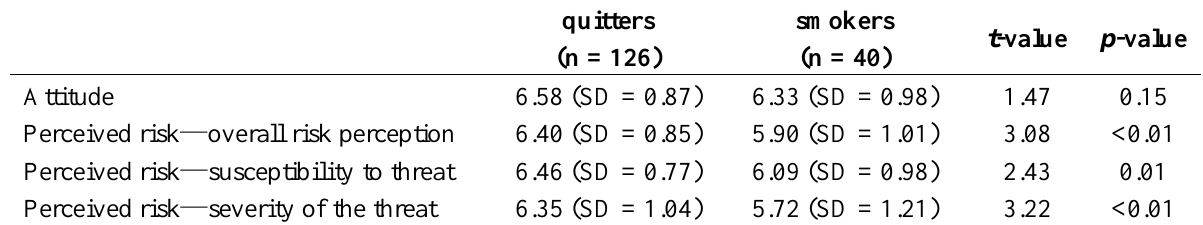
Table 5. Risk perception and attitude to anti pregnancy